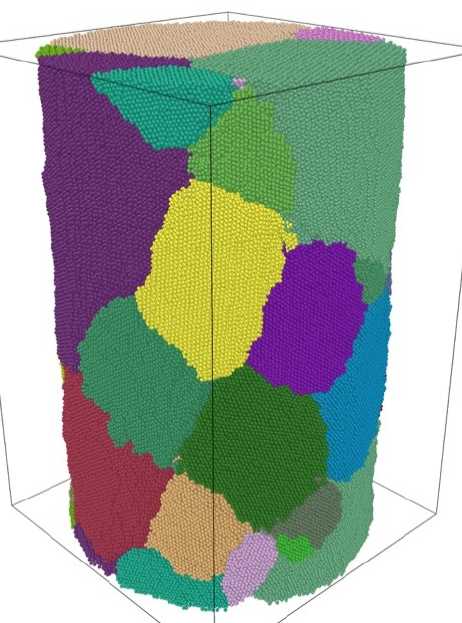
Figure 5. The grain structure (2180 K) resulting from the crystallization of the 25 nm diameter MG nanorod. Colors indicate different grain orientations.